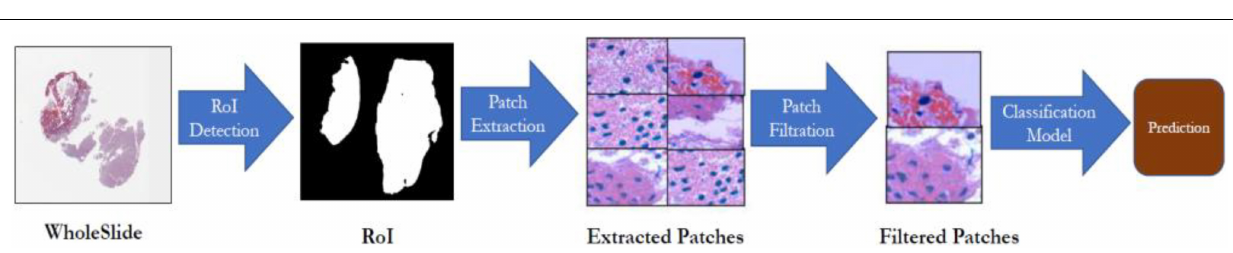
FIGURE 2 | Radiology image analysis. Images are pre-processed (i.e., skull stripping and co-registration) before they are analyzed through the remaining steps of the analysis pipeline. After the pre-processing step, tumor regions in the images are segmented via a CNN model. This step is followed by computation of a set of 105 radiomic features in segmented regions. The high-dimensional feature vector is reduced to a 16-dimensional feature vector using the principle component analysis method. A classification network is trained with these feature vectors.